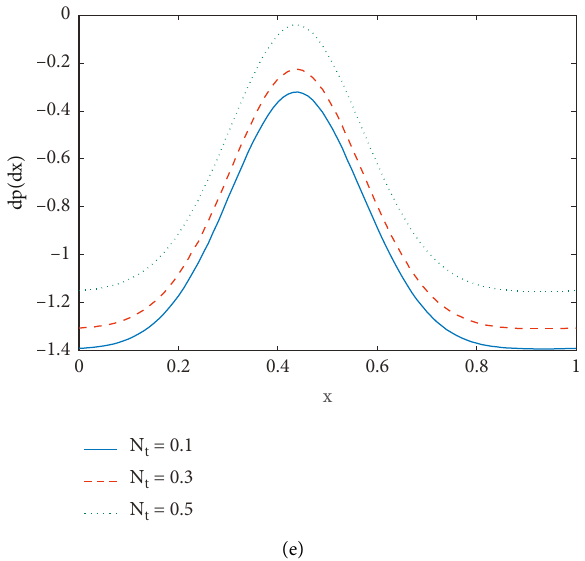
Figure 6: Effects of N